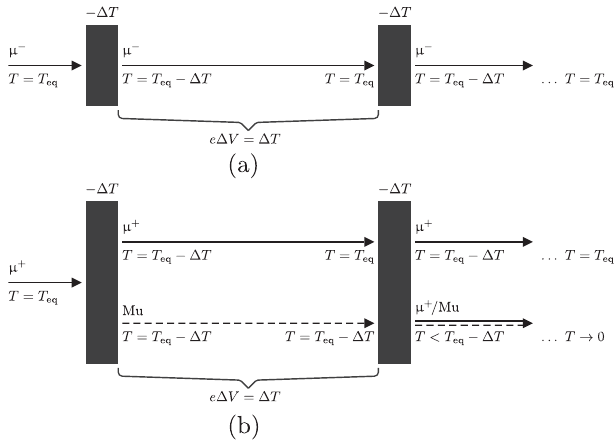
FIG. 6. Diagram of a foil-based cooling scheme for (cid:1) (cid:1) (a) and (cid:1) þ (b); the potential difference ( (cid:1) V ) between two foils (shown by thick vertical lines) is tuned to restore the energy lost ( (cid:1) T ) by a muon with kinetic energy T ¼ T eq